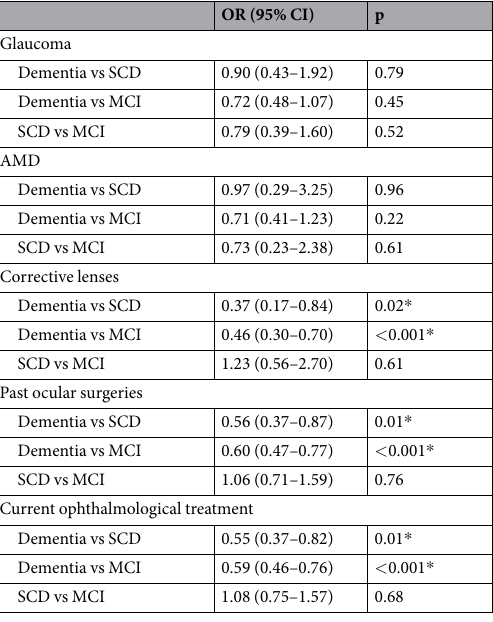
Table 4. Diagnostic group differences in past ophthalmological pathologies and treatments. A Multinomial Logistic Regression model including age, gender and years of education as co-variates was used to analyse group differences in past ophthalmological pathologies and treatments. For each comparison, the first listed group (Dementia, MCI or SCD) acted as reference. Statistical significance was set-up at p < 0.05. AMD = age- related macular degeneration; CI = confidence interval; MCI = mild cognitive impairment; OR = odds ratio; SCD = subjective cognitive